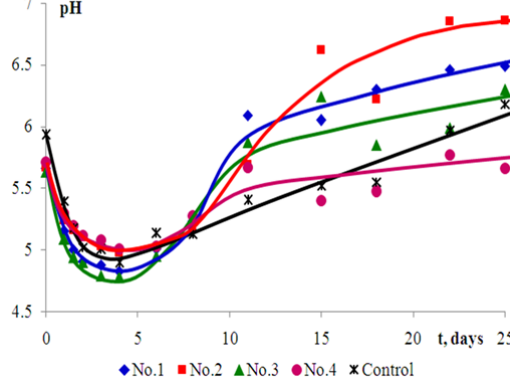
Figure 5. С hanges of pH - during the raw-drying